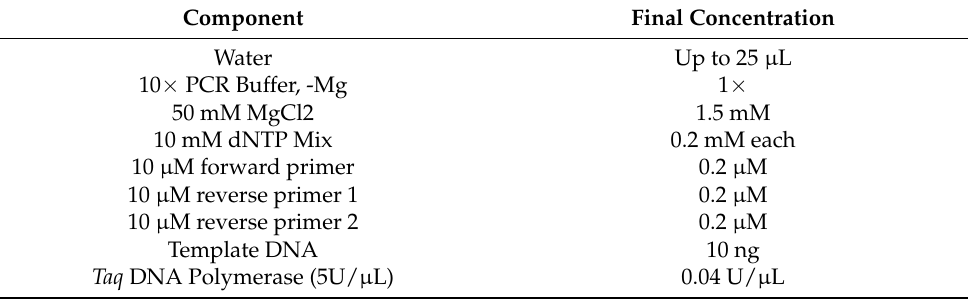
Table A2. PCR reaction set up for three-primers marker system.